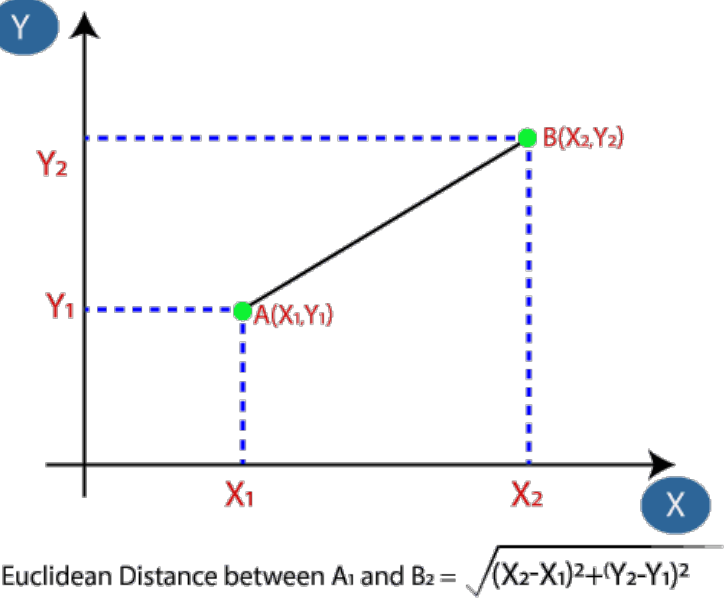
Figure 6. The Euclidean distance of KNN classifier [30].